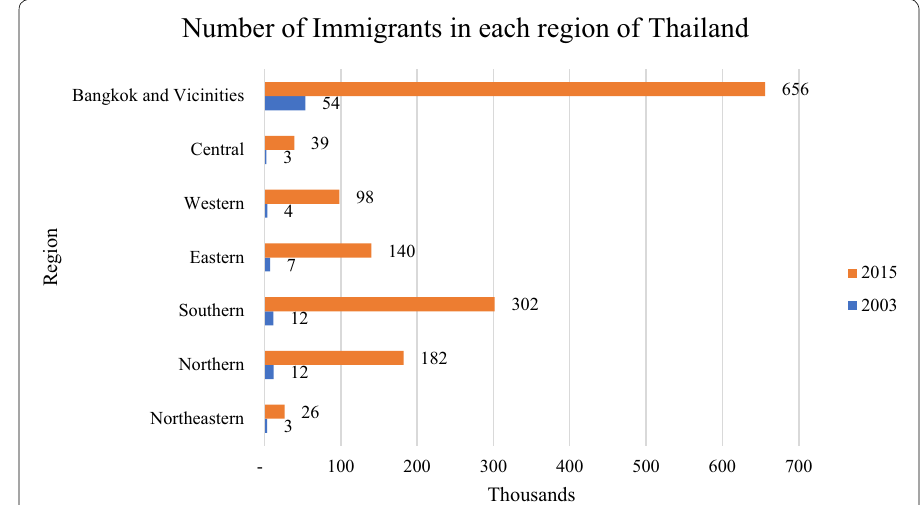
Fig. 2 Immigrant arrival rates, Thailand and Regions. Source : created by author using data from Office of Foreign Worker Administration in 2003 and